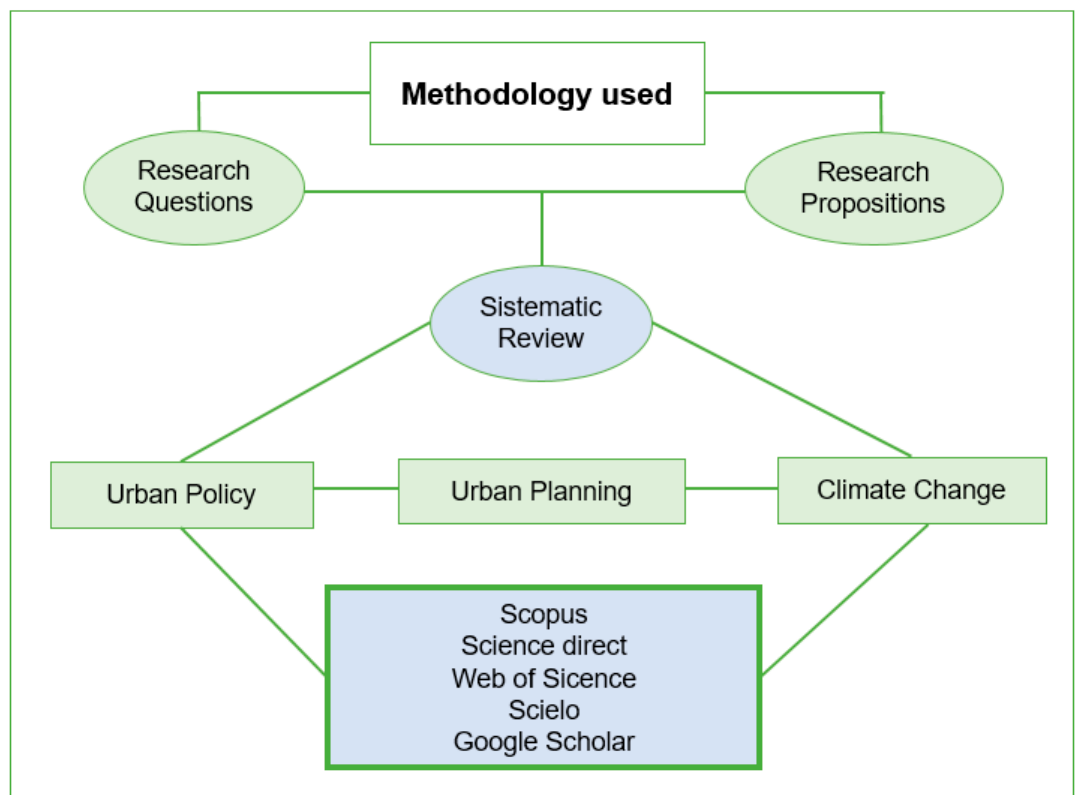
Figure 1. Methodological structure. (Source: The authors, 2022).